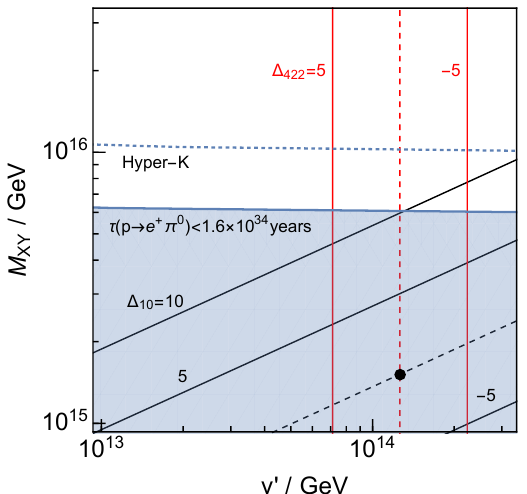
Figure 4 . Determination of v 0 and M XY in the 422 theory from gauge coupling uni(cid:12)cation alone. Contours of threshold corrections from scalars and fermions at the scale v 0 ((cid:1) 422 ) and at the scale M XY ((cid:1) 10 ) are shown in red and